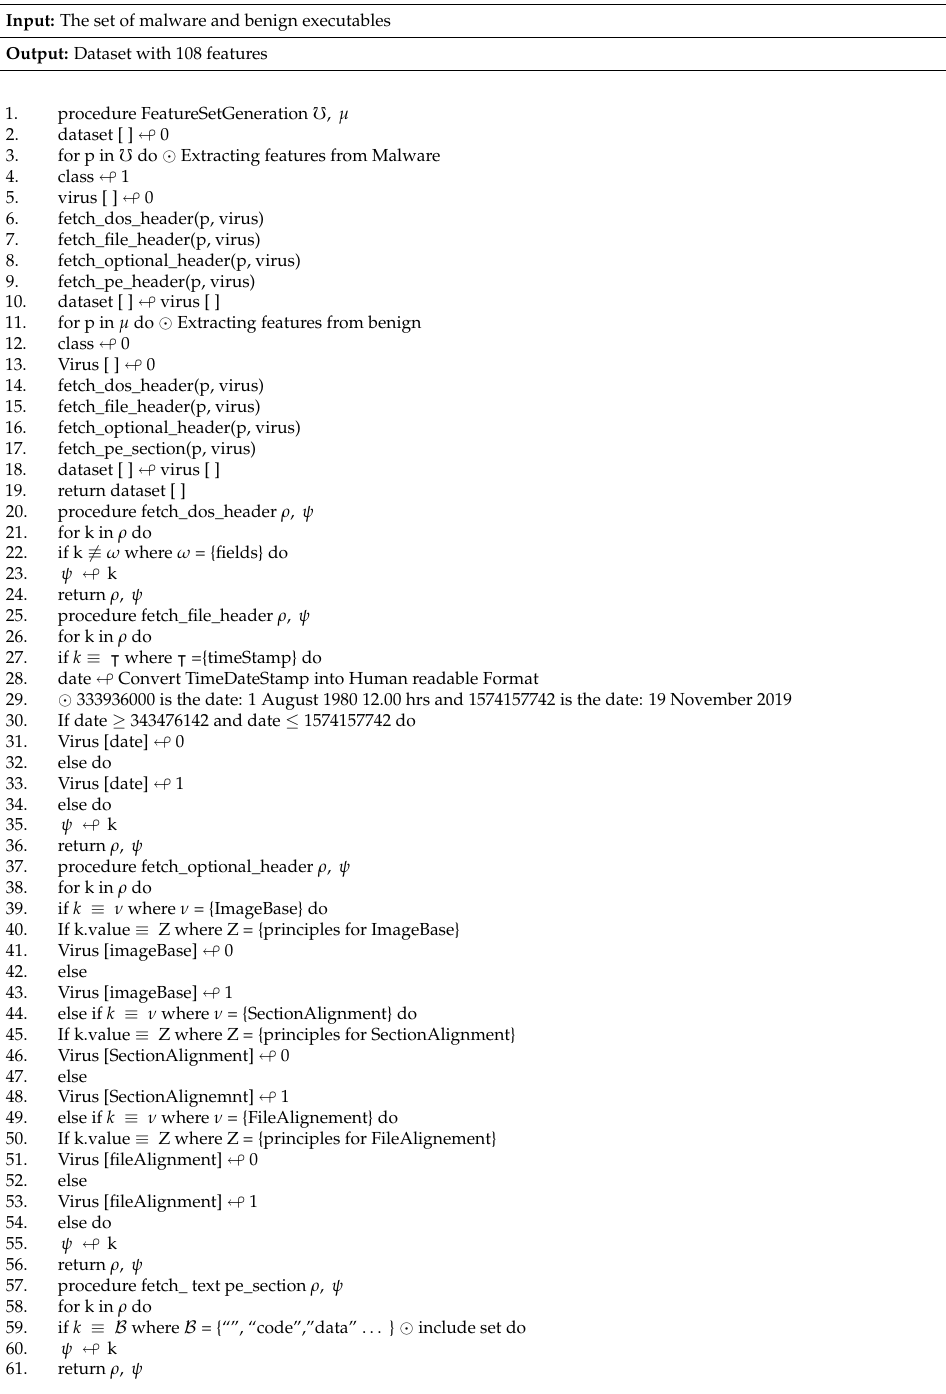
Algorithm 1. Feature extraction from the malware and benign executable